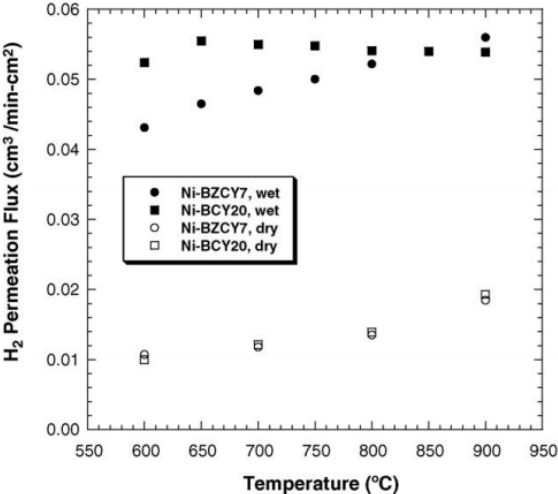
Figure 5. H 2 fluxes through Ni-BZCYb membrane feeding with dry and wet 4% H 2 [41].